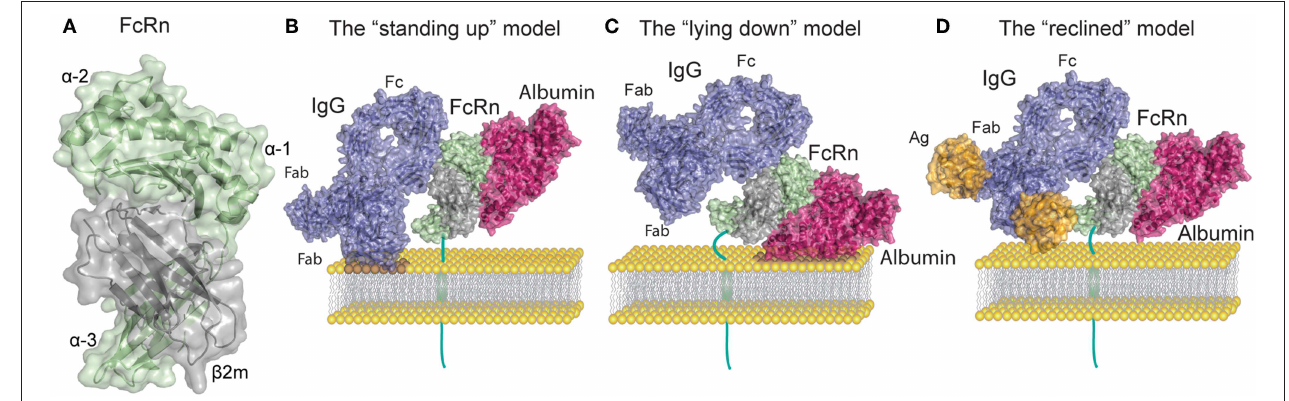
FIGURE 1 | FcRn structure and ligand binding. (A) Human FcRn heavy chain (green) is non-covalently associated with beta-2 microglobulin ( β 2 m, gray). (B) Topological representation of membrane associated FcRn in the standing up position. Bound albumin (magenta) and a monomeric IgG1 (blue) are modeled onto the structure of FcRn in complex with the Fc part of IgG MST and albumin. In this orientation possible clashes may occur between the Fab arms of the IgG and the membrane. For simplicity the figures depict stoichiometric FcRn and IgG ratio of one to one. (C) Topological representation of membrane associated FcRn in the lying down position. This orientation accommodates Fab arms of IgG yet it potentially confines the albumin binding site. (D) Topological representation of membrane associated FcRn bound to albumin and IgG in complex with a small antigen [guinea fowl lysozyme (orange)]. The reclined orientation of FcRn on the surface of the endosomal membrane may most proficiently accommodate both ligands. Binding of large IgG IC (not depicted) might impose a lying down FcRn position. The figures were made using Adobe Illustrator, PyMol and the crystal structure data from: FcRn in complex with the Fc part of IgG MST and albumin ( 23), a full-length human IgG1 antibody (24), and guinea fowl lysozyme (25), PDB IDs 4N0U, 1HZH and 1FBI